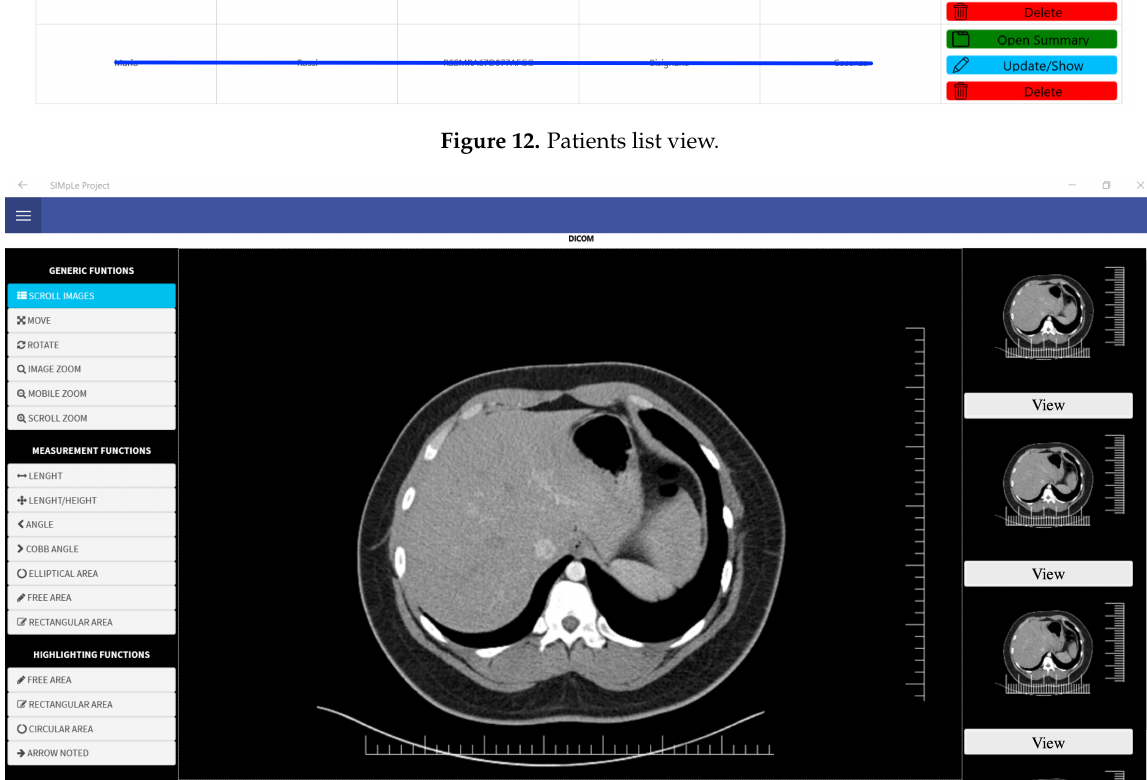
Figure 13. DICOM